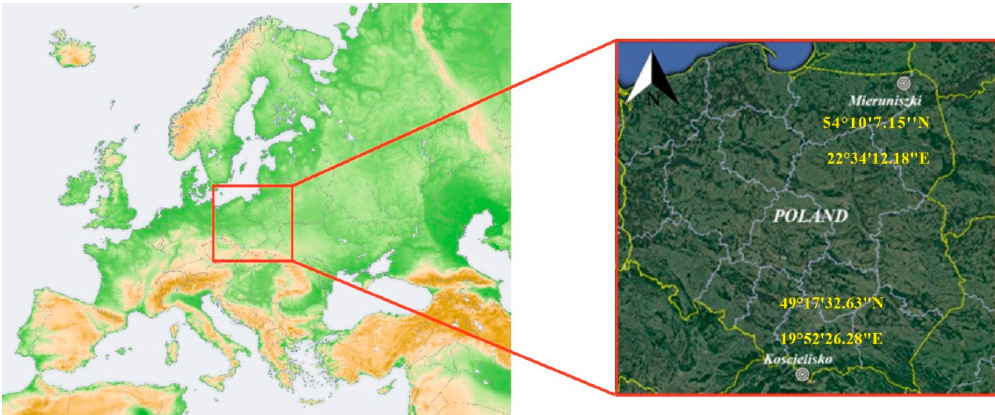
Figure 1. Localization of study area (left image based on Reference [41])